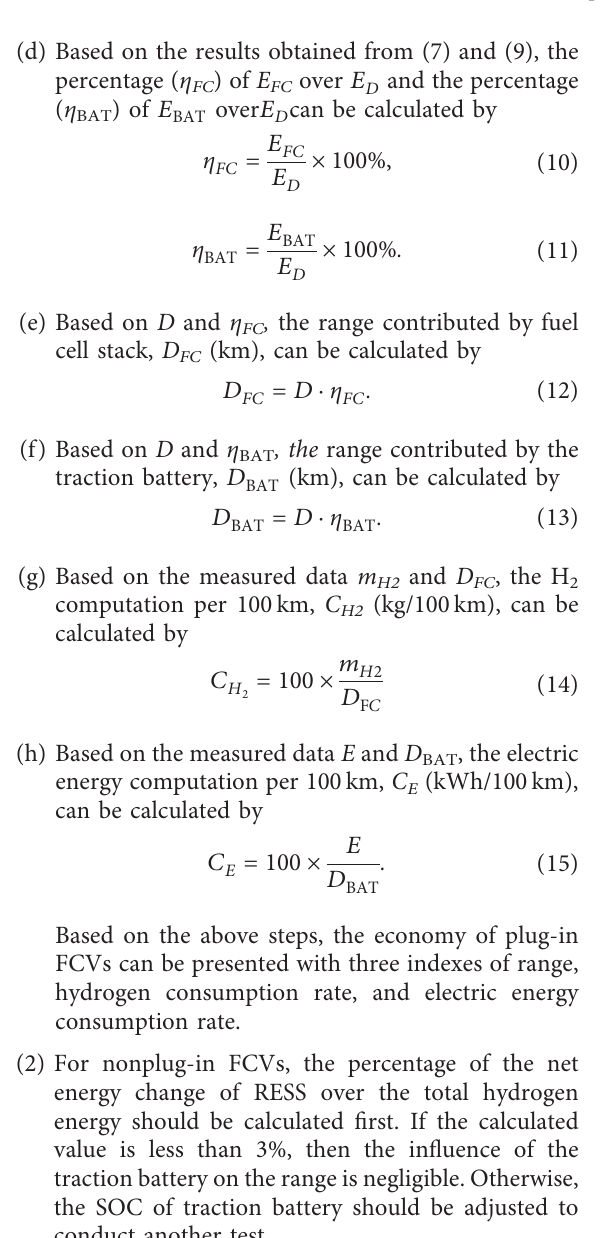
Figure 5: Sketch of power system of